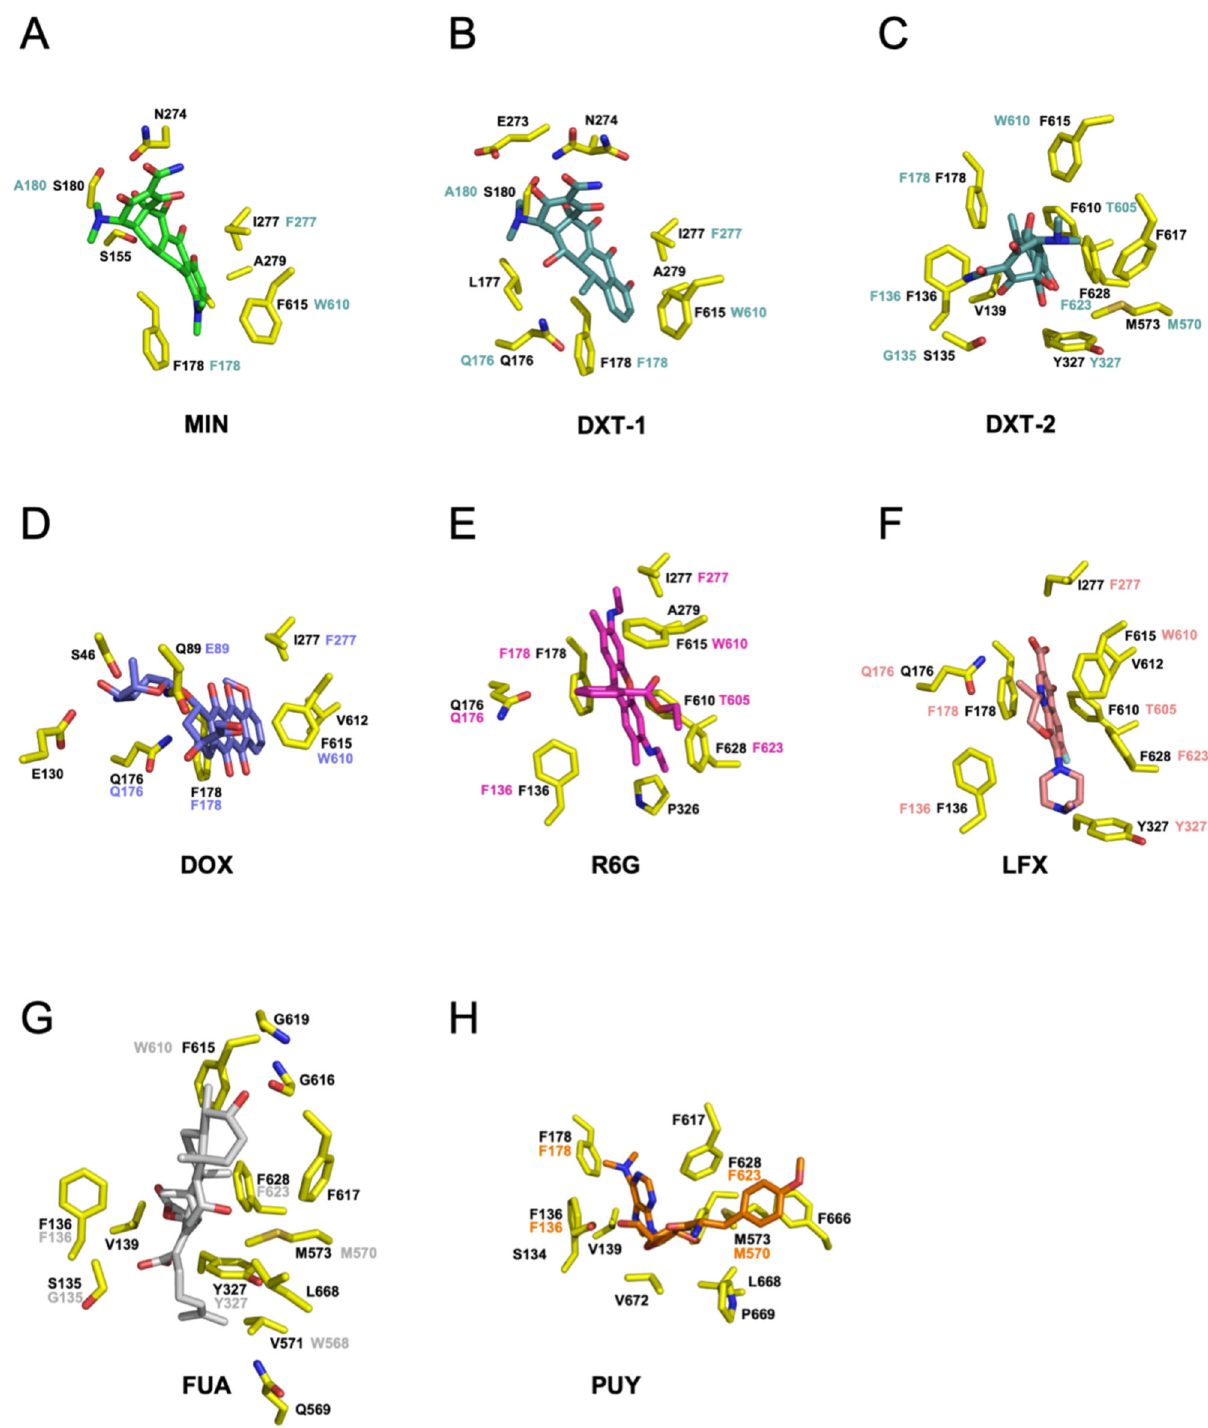
Fig. 4 Substrate binding to the AcrB T conformation. Binding sites within the AcrB DBP for A minocycline (MIN; carbon = green; PDB: 4DX5), B doxycycline (DXT-1) and C doxycycline (DXT-2); carbon = blue-green; this study), D doxorubicin (DOX; carbon = violet; PDB: 4DX7), E rhodamine 6G (R6G; carbon = pink; PDB: 5ENS), F levo fl oxacin (LFX; carbon = salmon; this study), G fusidic acid (FUA; carbon = gray; this study) and H puromycin (PUY; carbon = orange; PDB: 5NC5). AcrB residues involved in ligand binding are shown as sticks (AcrB; carbon = yellow; nitrogen = blue; oxygen = red; sulfur = gold) and by number, with colored numbers representing the corresponding AdeB with the side chains of S135, F136, V139, Y327, Q569, V571, with the binding site previously reported for rhodamine 6G 22 (Figs. 3D, 4E, F, 5 and Supplementary Figs. 8B and 9B). Like M573, F615, F617, G619, F628 and L668 (Figs. 3E and 4G and rhodamine 6G, levo fl oxacin interacts mainly with the hydro- Supplementary Figs. 8C and 9C). In addition, the fusidic acid phobic side chains of F178, F610 and F628. We found fusidic acid 3-hydroxyl group forms a hydrogen bond with the G616 main- bound to a more proximal part of the DBP, where it interacts chain carbonyl oxygen, while the fusidic acid carboxyl group is